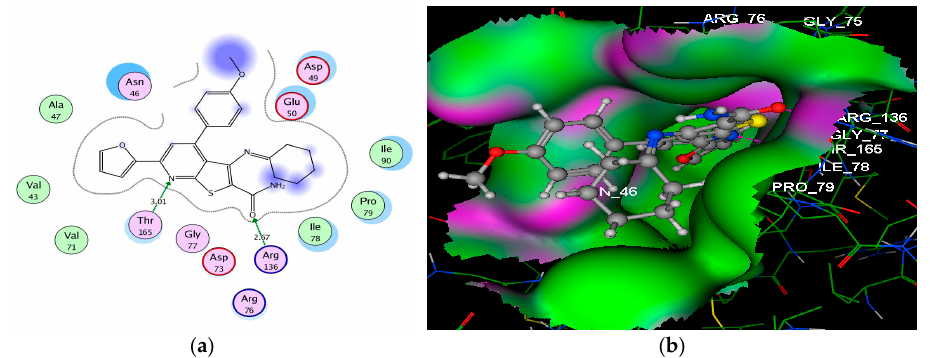
Figure 4. 2D ( a ) and 3D ( b ) diagrams illustrating the binding patterns of compound 4a into the ATP-active pocket of E. coli DNA gyrase B (PDB code: